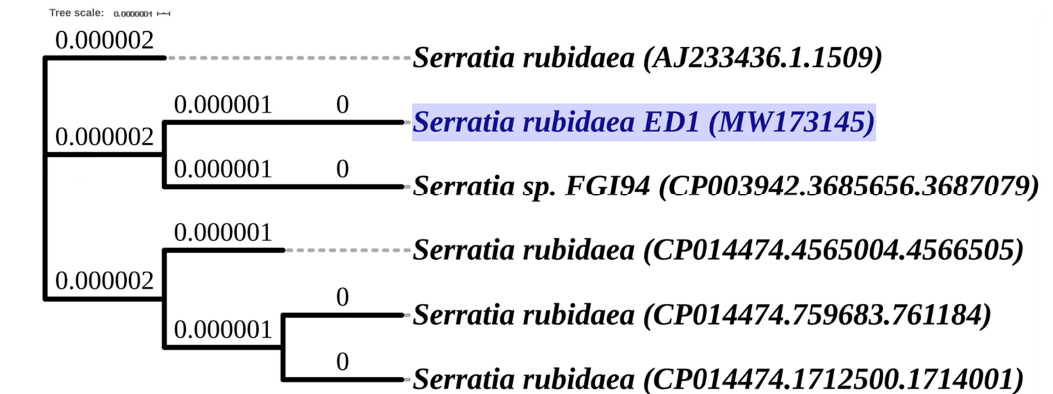
Figure 2. Phylogenetic tree of selected bacterium Serratia rubidaea ED1 (MW173145) based on the PHYLIP (PHYLogeny Inference Package) Neighbor-Joining method of the 16S rRNA gene sequences using (Unipro UGENE software, version 1.32.0. Branch lengths are displayed as age. The 16S rRNA gene sequences and tree of related species were downloaded from the High-Quality Ribosomal RNA database (SILVA).